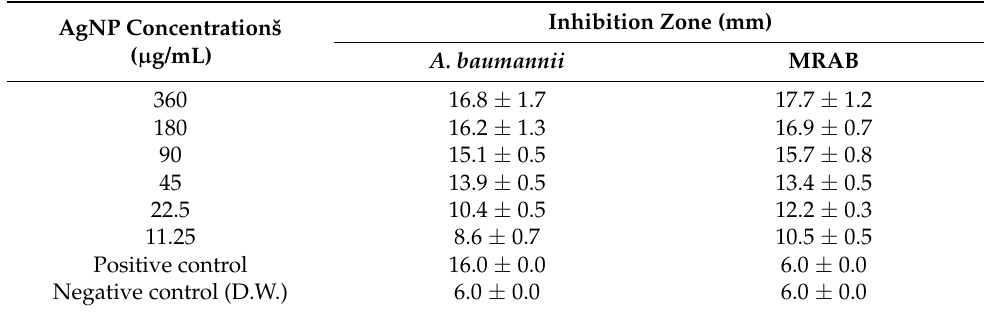
Figure 7. Antibacterial effects of AgNPs using A. catechu against A. baumannii and multidrug-resistant Acinetobacter baumannii (MRAB). ( a , b ): inhibition zone of AgNPs against A. baumannii . ( c , d ): inhibition zone of AgNPs against MRAB. The AgNP treatment concentrations were 360, 180, 90, 45, 22.5, and 11.25 µ g/mL. Table 5. Diameter of inhibition zones of AgNPs using A. catechu against A. baumannii and MRAB.